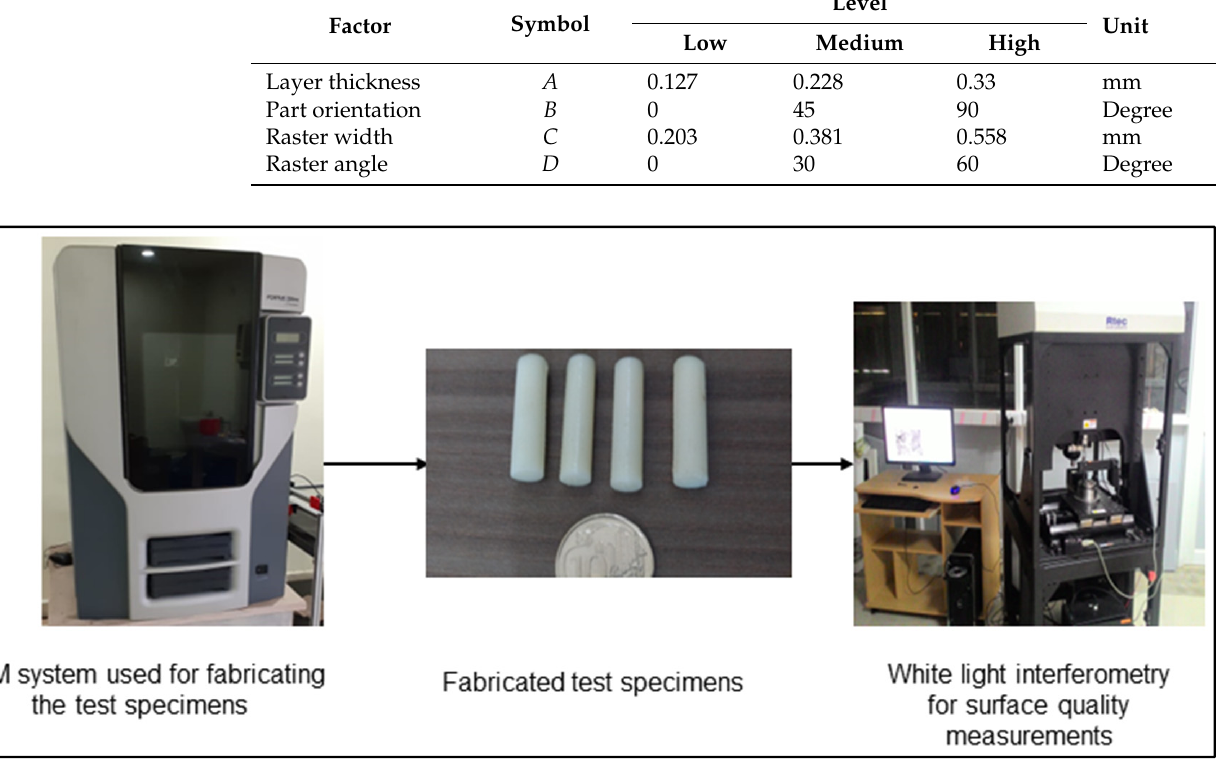
Figure 1. FDM process and surface roughness measurements. Table 2. FDM experimental design and measured responses.